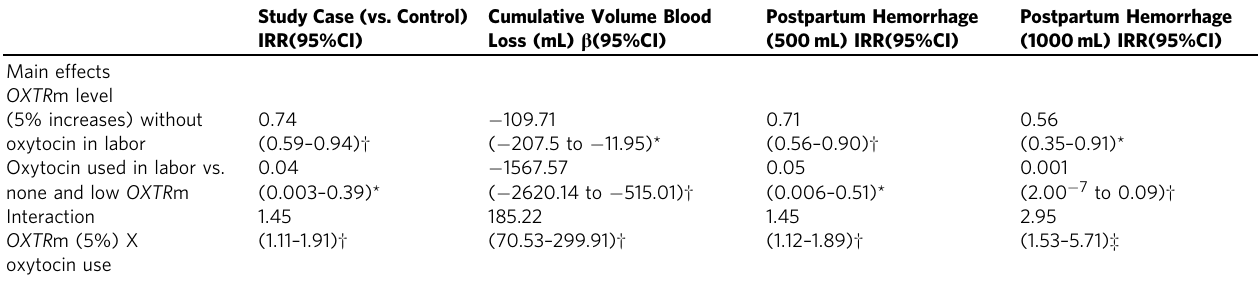
Models included replicate variability, parity, antibiotic administration during labor and body mass index at delivery and used Poisson regression or generalized linear modeling (gamma distribution) for total blood